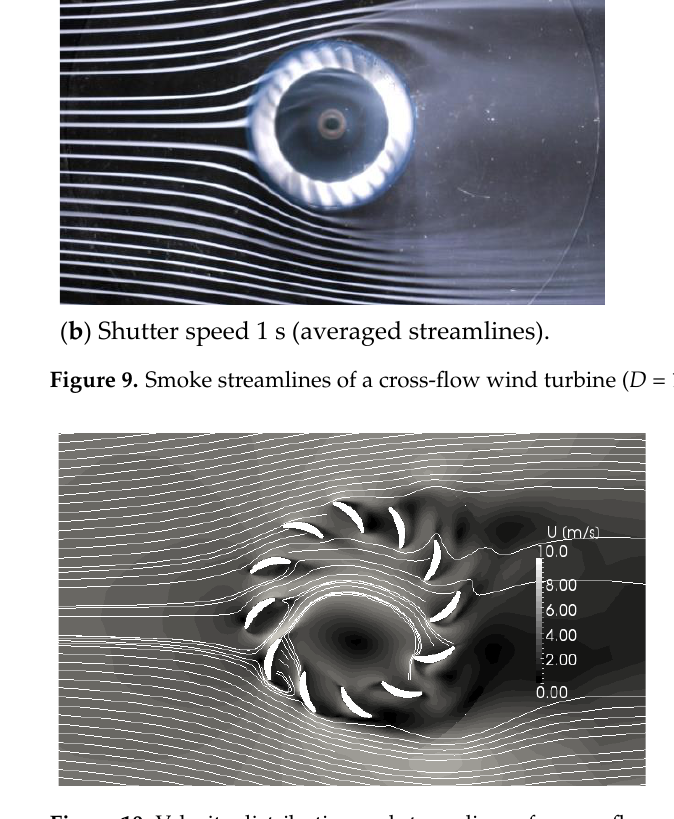
Figure 10. Velocity distribution and streamlines of a cross-flow wind turbine obtained by OpenFOAM numerical calculation ( D = 114 mm, λ = 0.436, and U ∞ = 6 m/s).